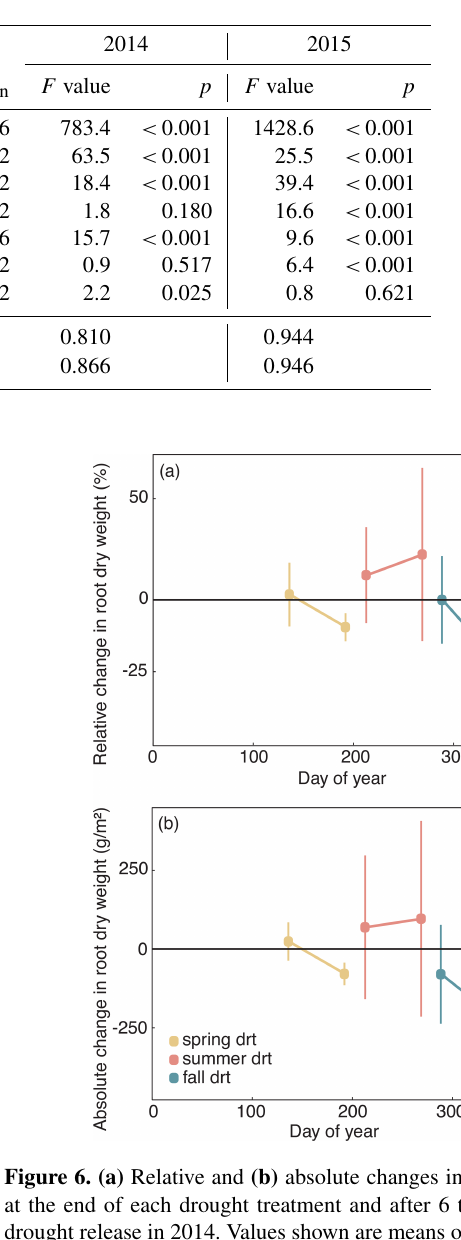
Table 4. Summary of analysis for the effects of season, drought treatment, grass species and cultivars (grass) and their interactions on temperature-weighted growth rates (DMYT sum ; naturally log transformed) from the second post-drought growth period. See Table 3 for additional explanations.